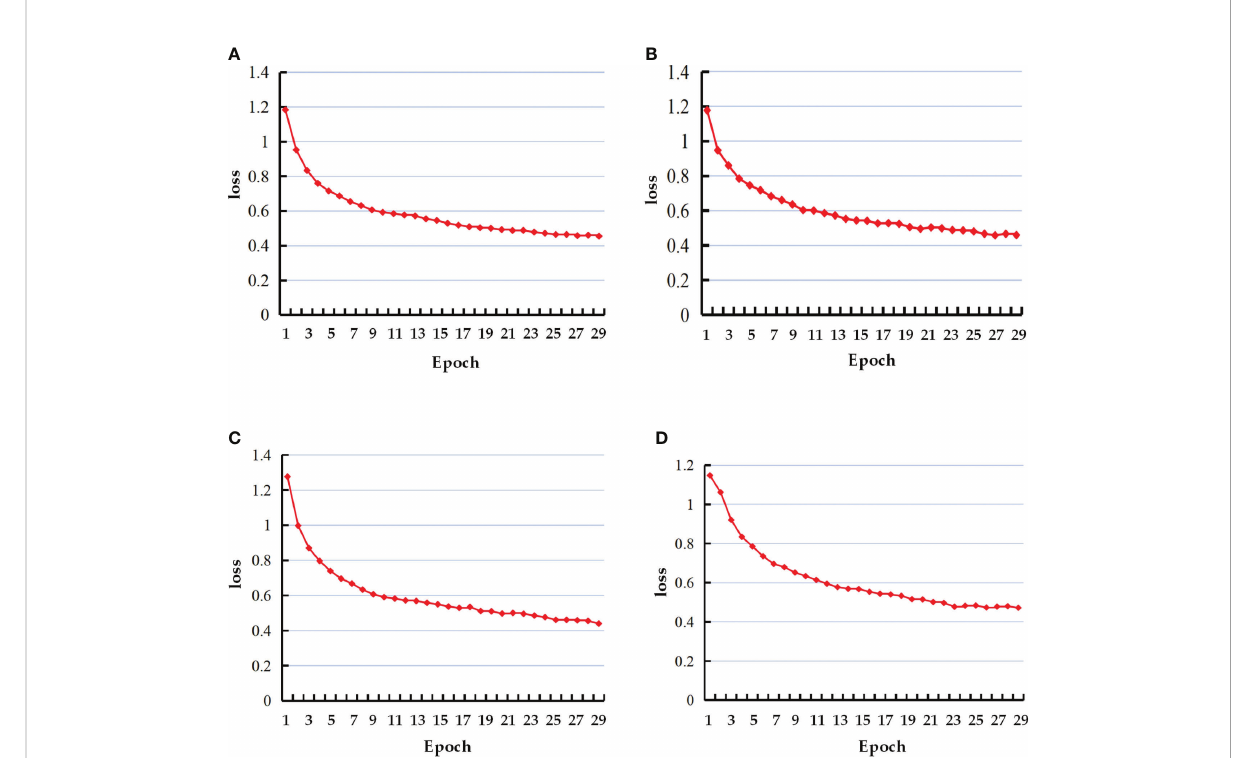
FIGURE 9 Loss curves of the four models. (A) Mask-RCNN+ResNet50; (B) Mask-RCNN+ResNet101; (C) Improved Mask-RCNN+ResNet50; (D) Improved Mask-RCNN+ResNet50.